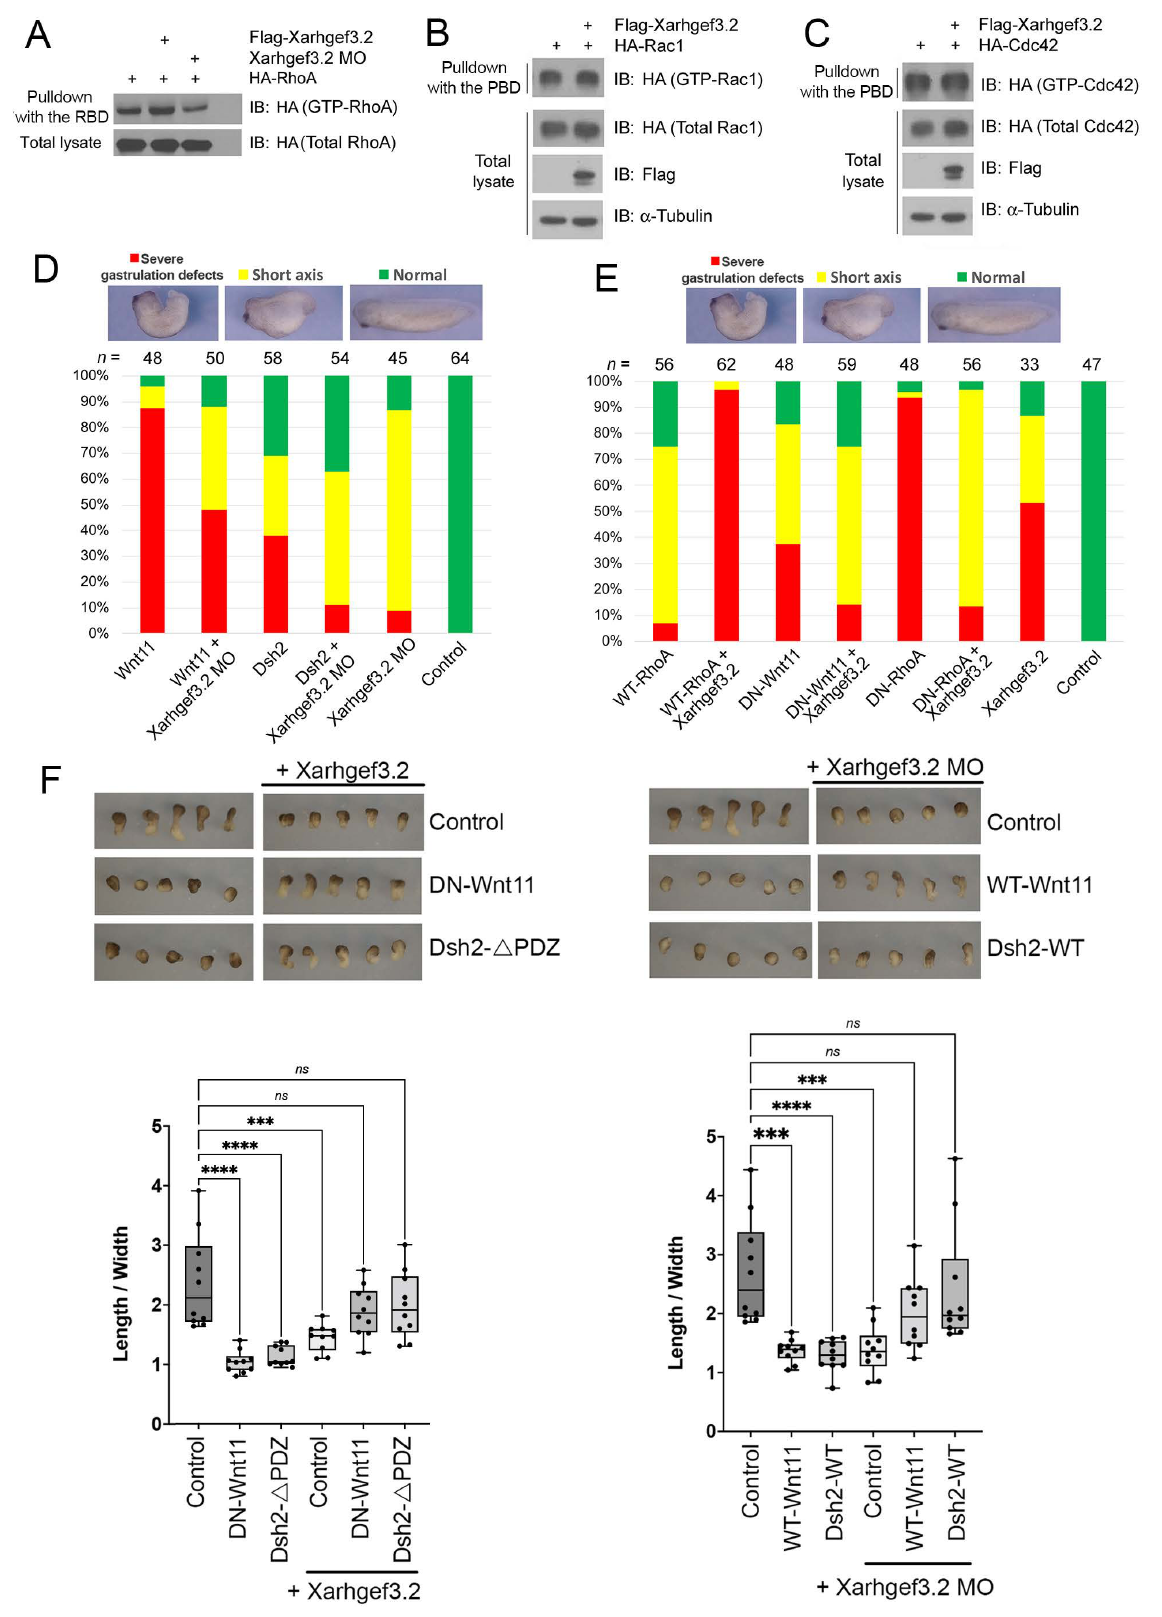
Figure 5. Xarhgef3.2 regulates CE movement in a noncanonical Wnt signal cascade. ( A ) The DMZ ex- plants injected with Xarhgef3.2 into the dorsal marginal zone at the four-cell stage (25